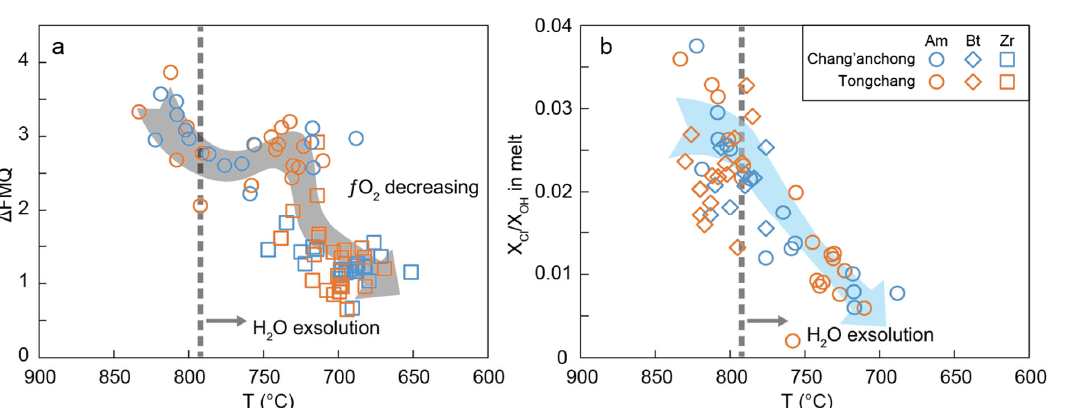
Figure 8. ( a ) The calculated P–T conditions for Tongchang and Chang’anchong quar tz syenite por- phyries. Cross bars indicate the P–T uncertainties [69]. Liquidus for amphibole is delineated with black solid lines, labeled on their unstable side [90]. The wet granite solidus (Wgs) line is delineated with a black solid line [89]. The steep grey dashed lines are undersaturated liquidus (with wt% H 2 O labeled) and the subhorizontal dashed lines are H 2 O solubility limits (also labeled as H 2 O saturated) [88,89]. Am, amphibole; Wgs, wet granite solidus. ( b ) The calculated pressure condition vs. magmatic H 2 O content for Tongchang and Chang’anchong quartz syenite porphyries. Cross bars indicate the P– H 2 O uncertainties [69]. The dashed line shows the H 2 O solubility curves [88]. ( c ) The calculated T–H 2 O conditions for Tongchang and Chang’anchong quartz syenite porphyries. Cross bars indicate the T– H 2 O uncertainties [69]. The thick dashed line represents the H 2 O exsolution process.